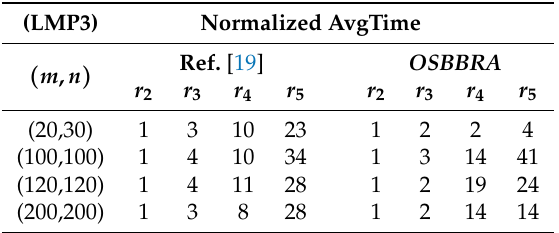
Table 9. Computational results on (LMP3) and comparison with results reported in